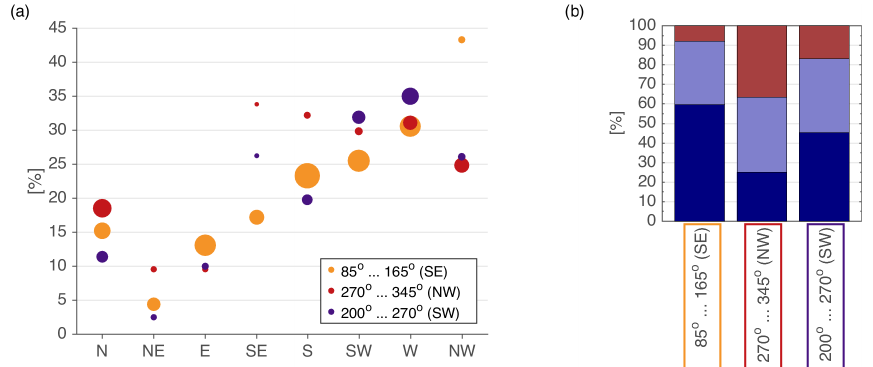
Figure 13. Fraction of time with P-MPC occurring for each surface wind direction and weather type regime (a) . The size of the dots represents the amount of data available to compute the value. The fraction of P-MPC cases classified as coupled, predominantly decoupled, and fully decoupled for each surface wind direction mode (b)